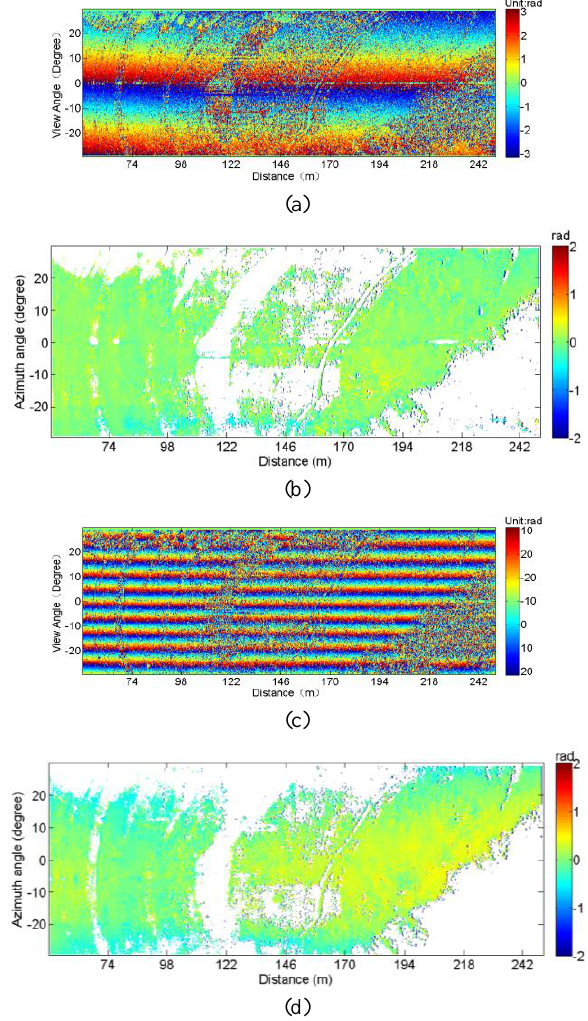
Figure 1. Geometrical relationship of the three directions and simulated results. (a), (b) Azimuth direction. (c), (d) Range direction. (e), (f) Vertical direction.